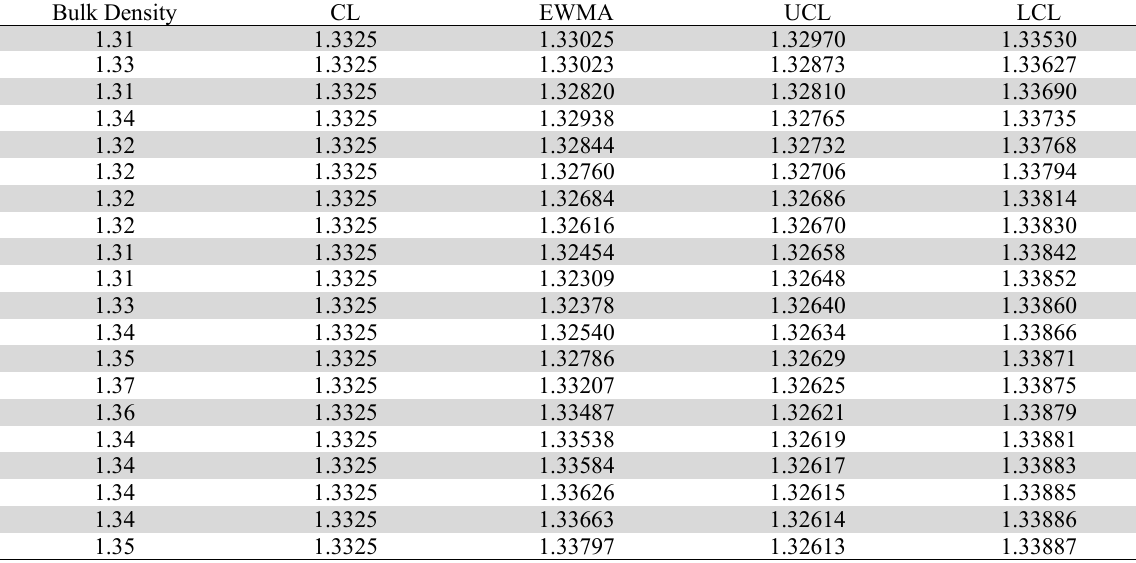
Computation of Control Limits for EWMA Chart